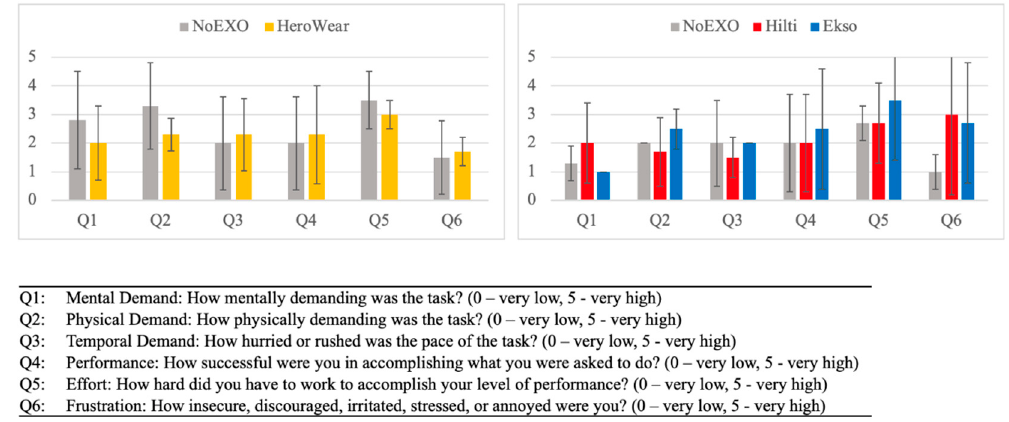
Figure 16. Perceived Task Loads with/without EXOs.